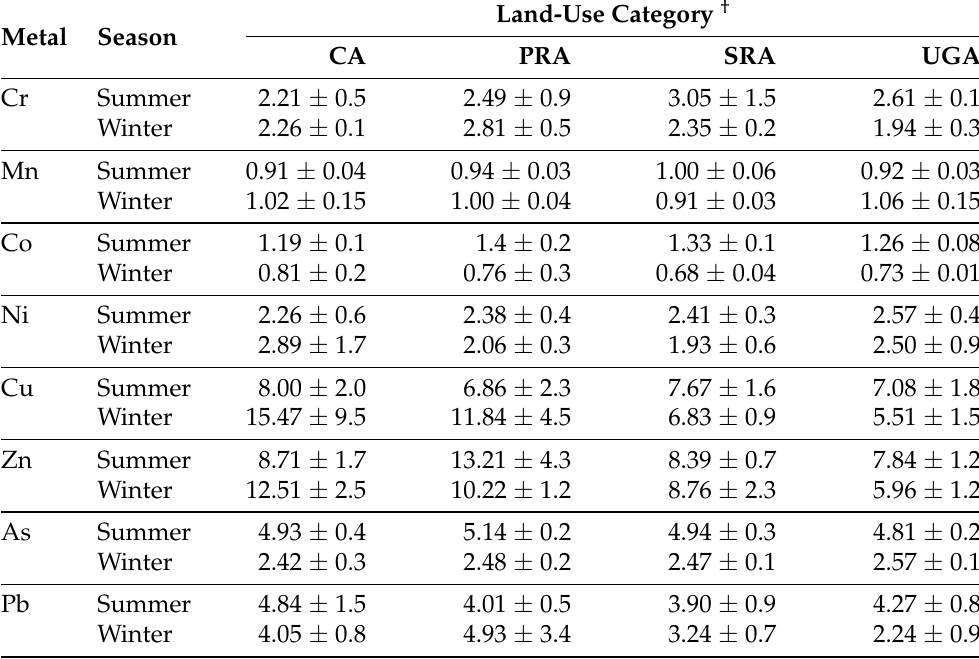
Table 3. Enrichment factor ( EF ) of heavy metals in roadside dust at different land-use categories in Dhaka city of